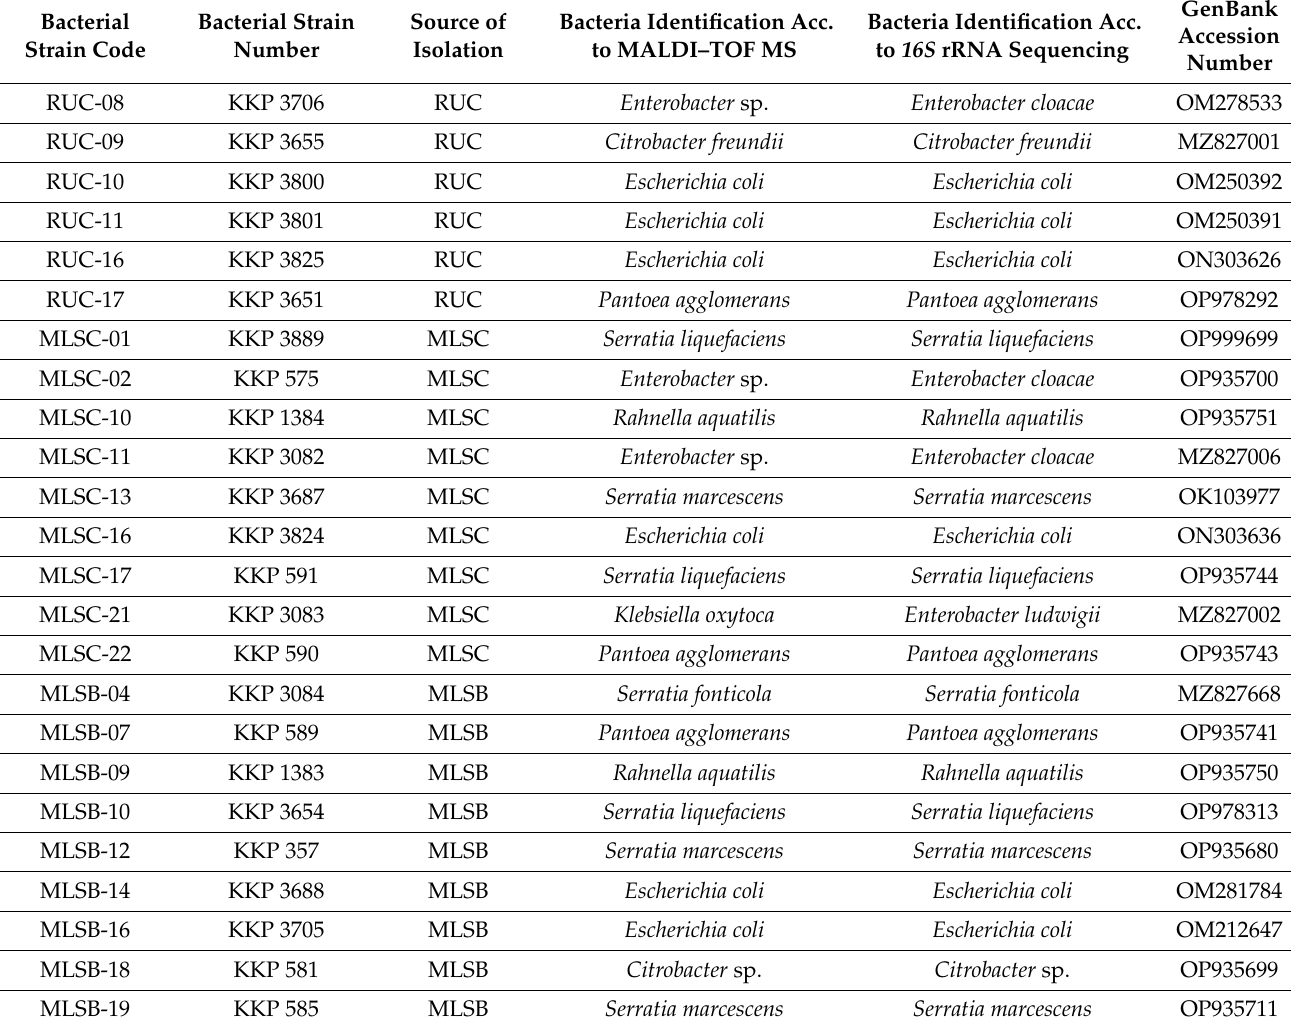
Table 2. Source of isolation and taxonomic identification of bacterial